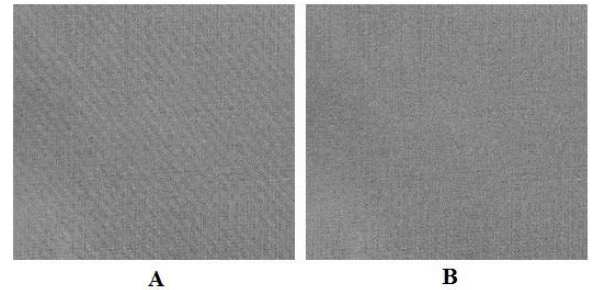
Figure 4. A) The image in Figure 3 (b), B), The result